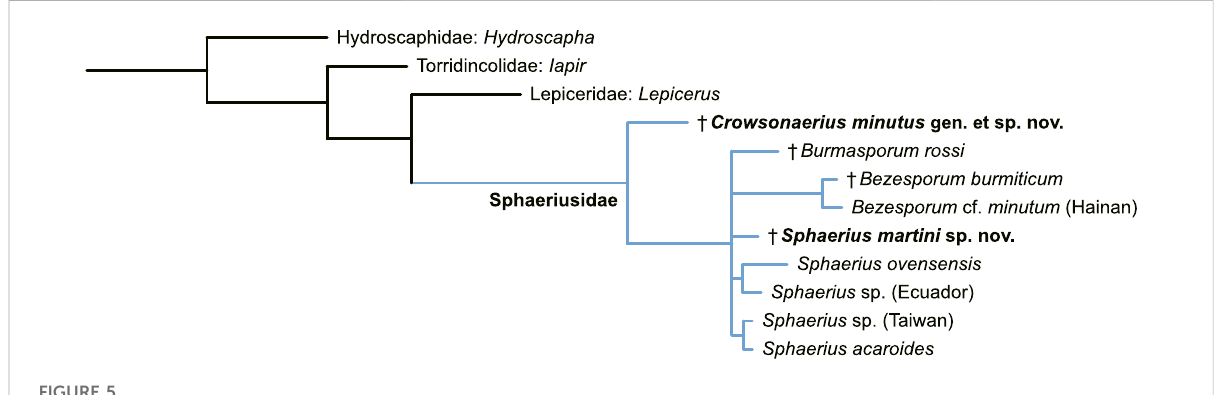
FIGURE 5 Suggested placement of Sphaerius martini and Crowsonaerius minutus within Sphaeriusidae. Tree resulting from the Bayesian analysis constrained by a molecular backbone